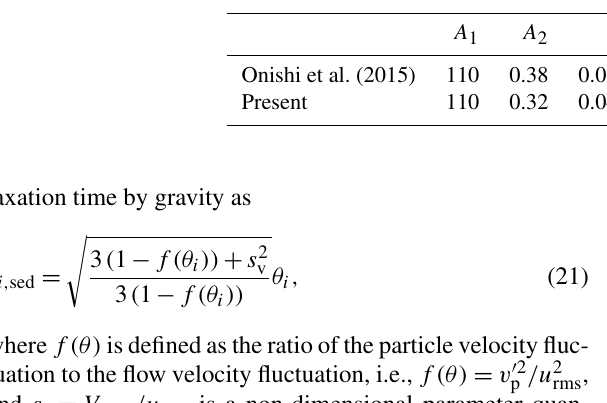
Table 1. Parameter values for g 11